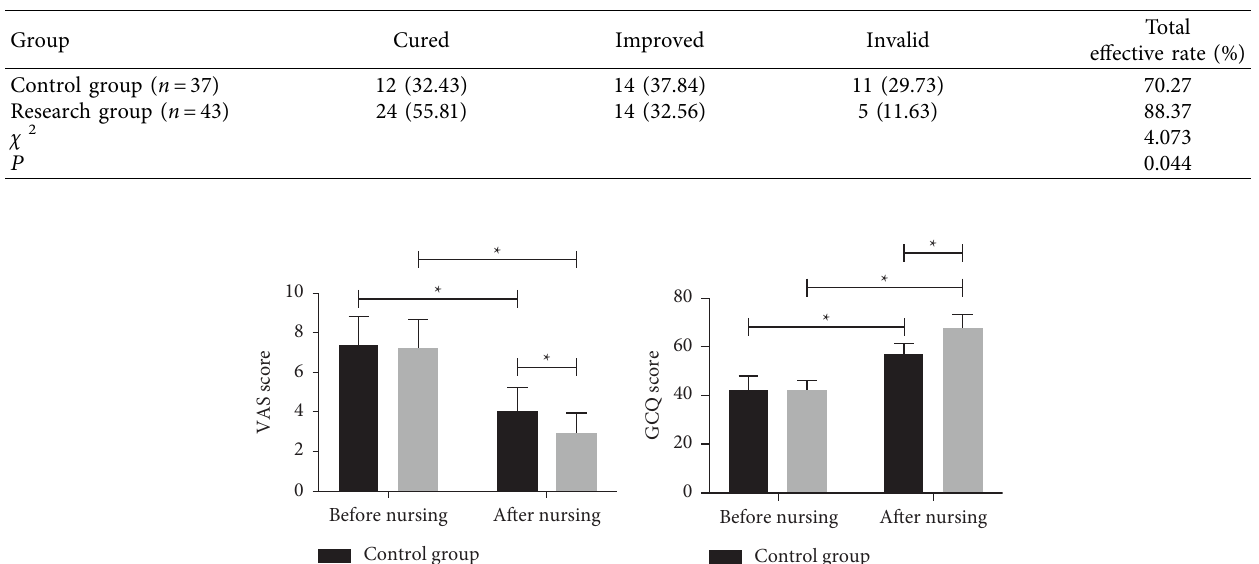
Figure 1: Postoperative recovery between two groups. Note: (a) comparison of time of frst anal discharge; (b) comparison of time of frst bed activity; (c) comparison of time of intestinal function recovery; (d) comparison of length of hospital stay. ∗ P < 0.05. Table 2: Comparison of nursing efciency.